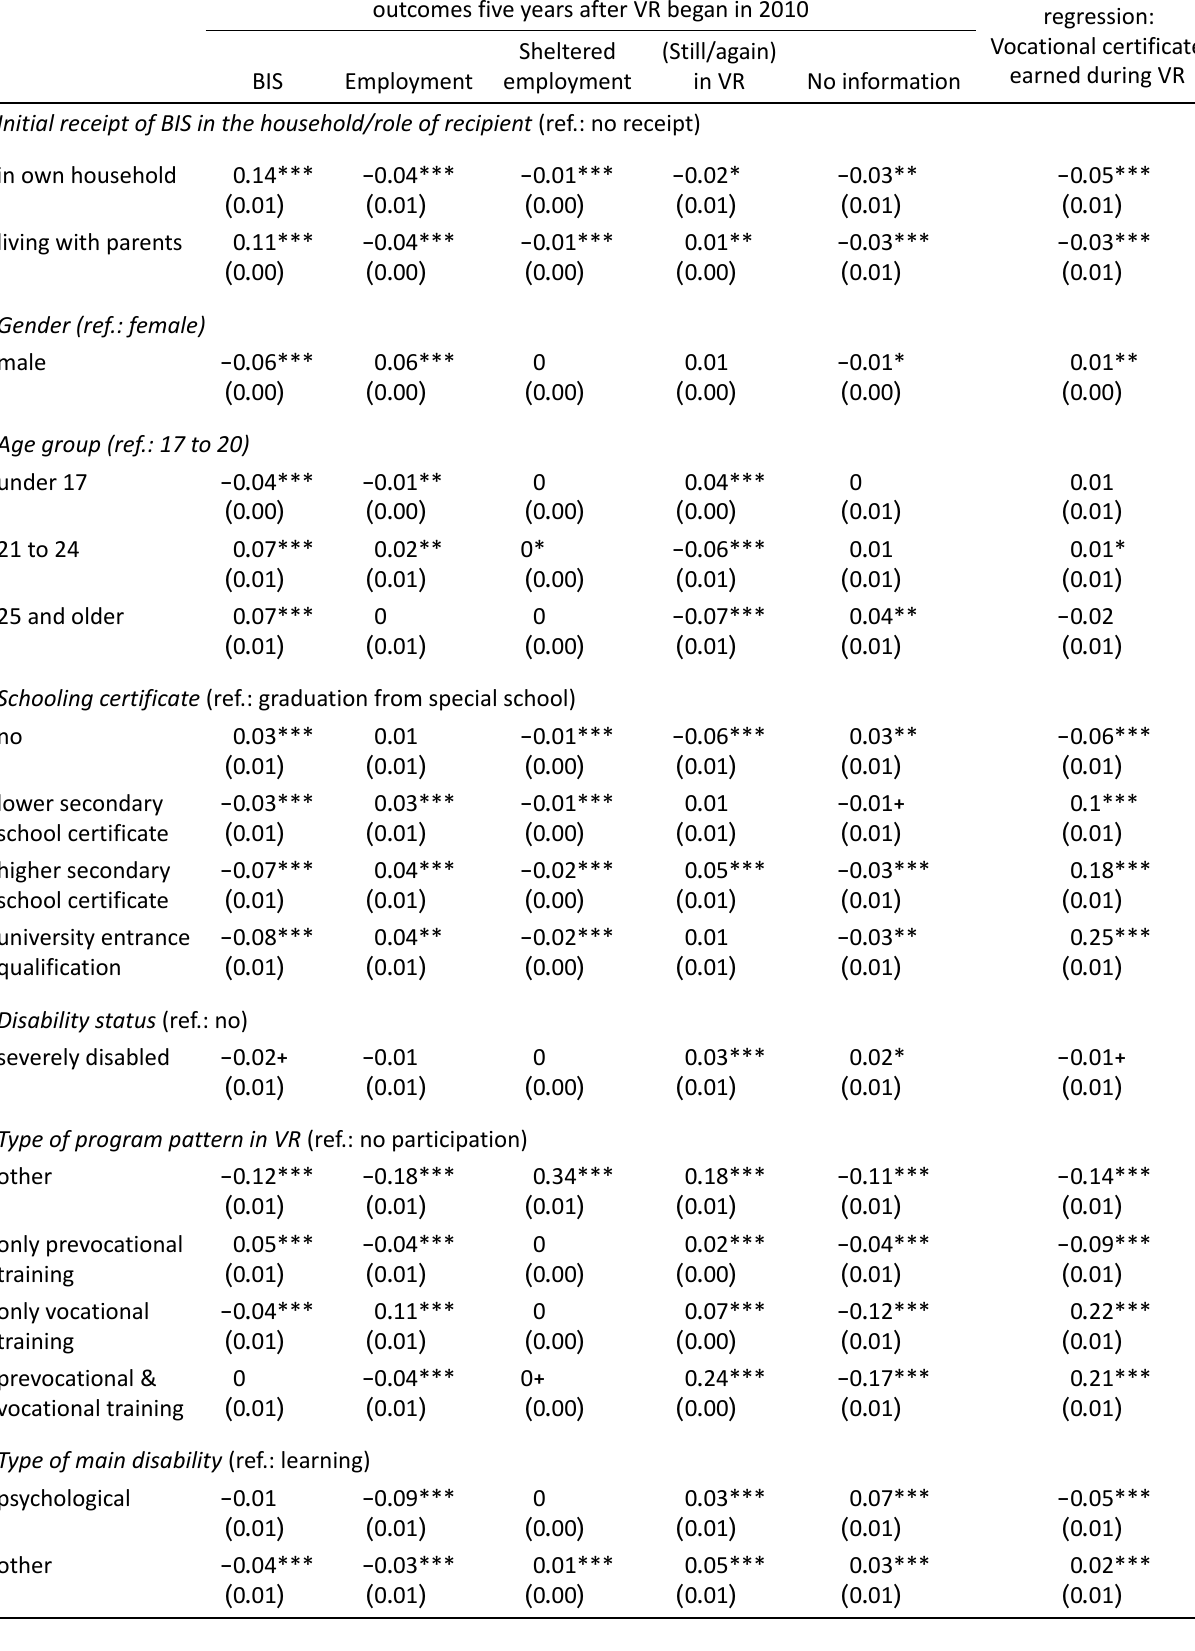
Table 2. Results of the multivariate analyses. Model 1a: Multinomial logistic regression: Labor